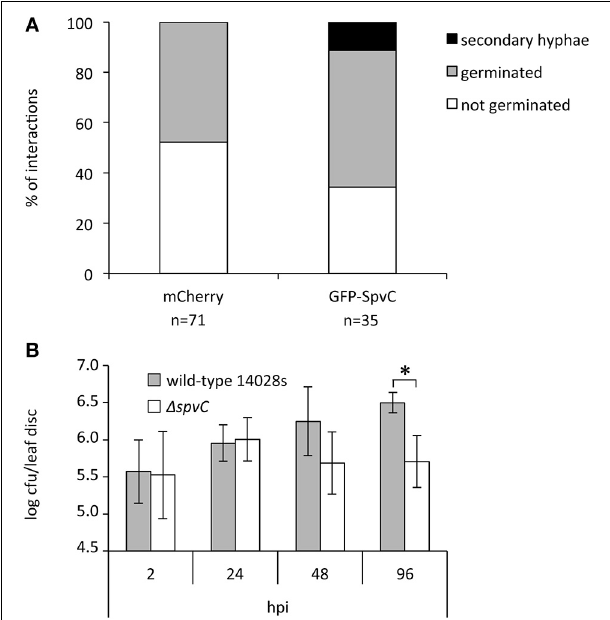
FIGURE 6 | Expression of SpvC breaches the non-host resistance in Arabidopsis to powdery mildew fungus and its lack renders Salmonella bacteria less virulent toward plants. (A) Leaves from soil-grown Arabidopsis plants were co-transformed with p35S-GFP-SpvC and p35S-mCherry plasmids or transformed with p35S-mCherry plasmid alone, and inoculated with Blumeria graminis f. sp. hordei ( Bgh ) conidia. 48h after inoculation, leaves were stained with calcofluor to visualize fungal growth. The outcome was counted on cells transformed with mCherry or GFP-SpvC. Three types of interaction were observed: non-germination, germination without further development, and formation of secondary hyphae. The experiment was repeated three times with similar results. (B) Proliferation of the (cid:2) spvC mutant in planta was tested on 4-week old Arabidopsis plants, syringe-infiltrated with bacterial solutions. The data represents mean values ± SD from five biological replicates; ∗ represents p < 0.05 in Student’s t -test, hpi; hours